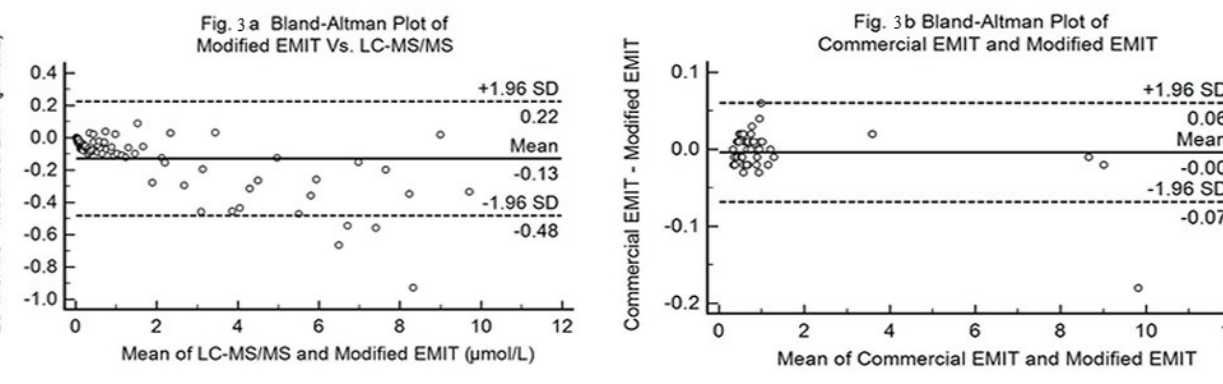
FIGURE 3b - Bland-Altman plot of Modified EMIT and Commercial EMIT